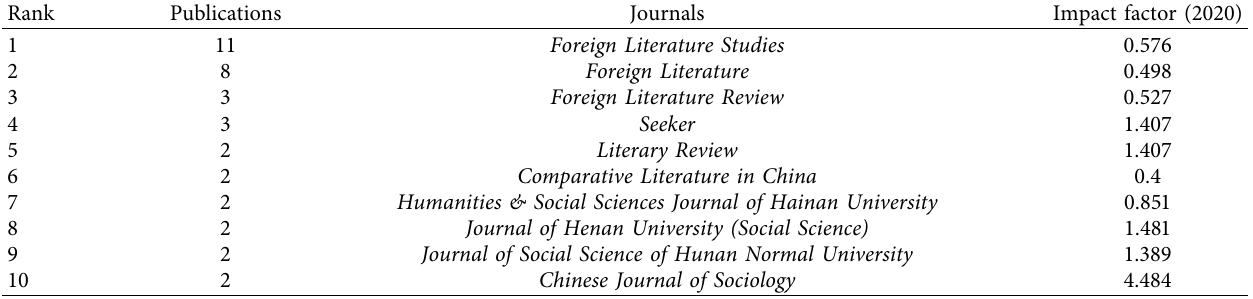
Table 11: Top 10 major journals and impact factor.